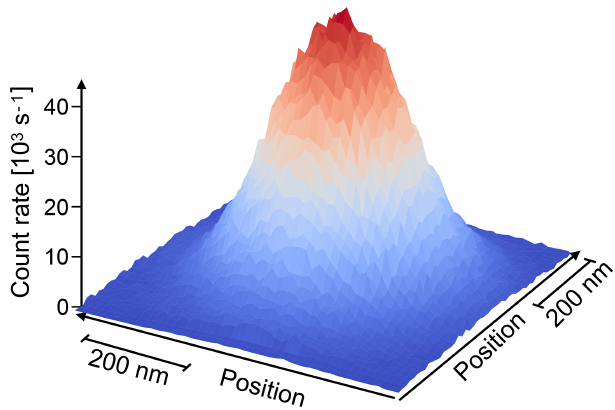
Figure 10. Photon count rate from a single NV centre in diamond measured as a function of